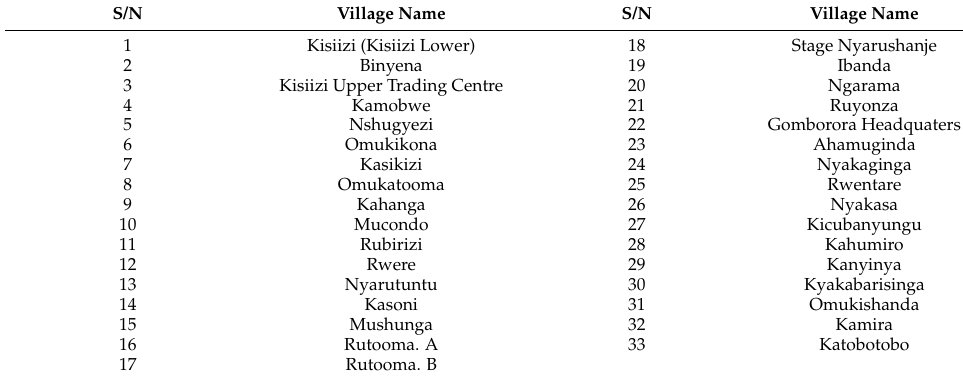
Table 1. A list of villages supplied by KHPMG. S/N Village Name